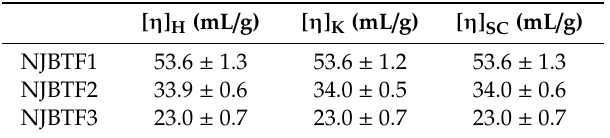
Table 1. Intrinsic viscosity of C. moschata polysaccharide